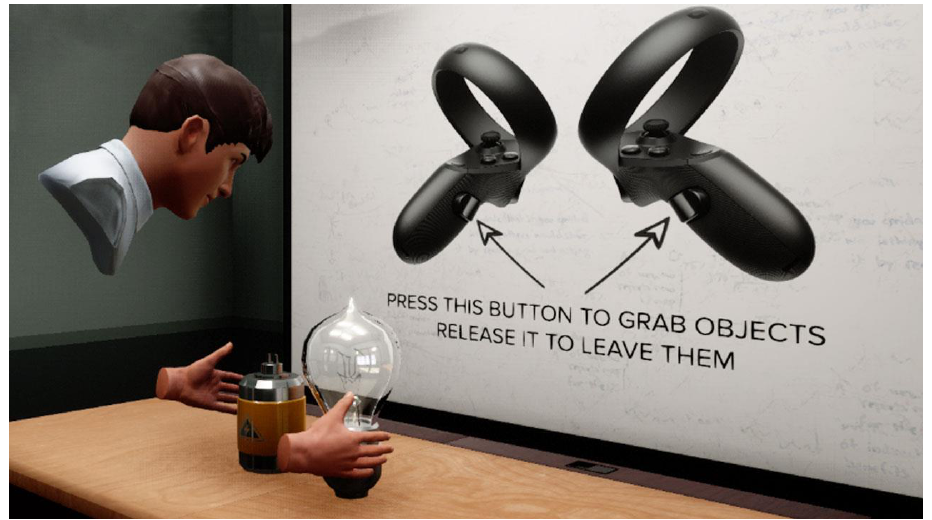
Figure 2. Diagram showing the iVR controllers with annotations anchored to them and how to use them.